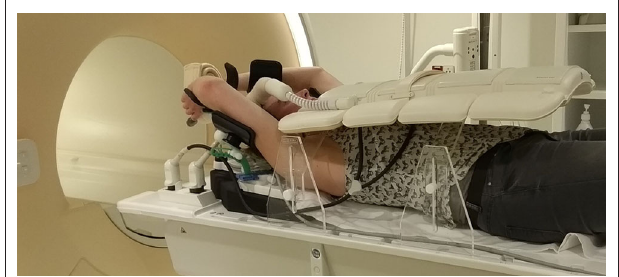
FIGURE 1 | Supine patient setup for MRI simulation. In this setup, a 5-degree inclined wedge is used. Height-adjustable coil bridges are used as support for the anterior receiver coil to prevent deformation of the body contour.